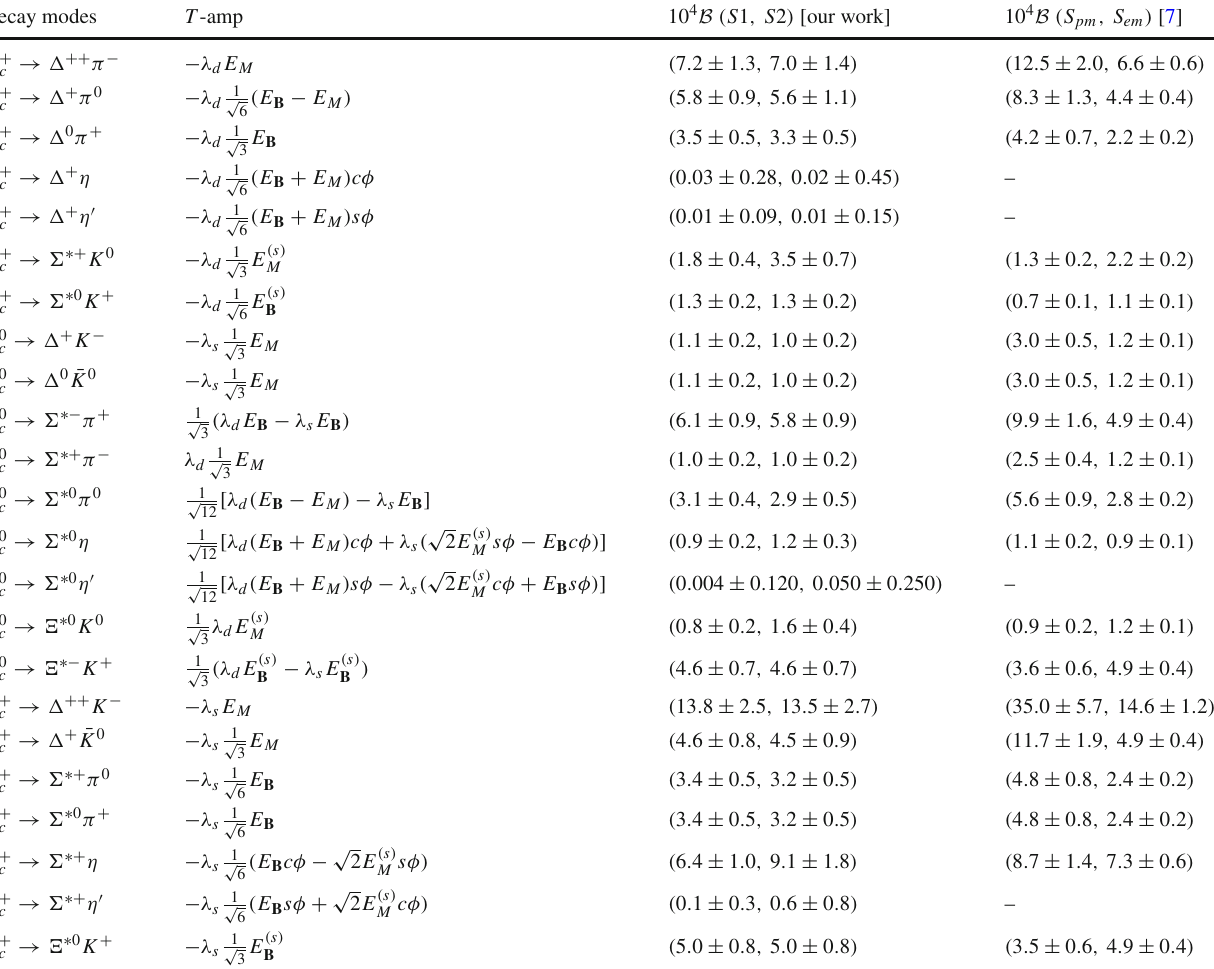
Table 2 Singly Cabibbo-suppressed B c → B ∗ M decays Decay